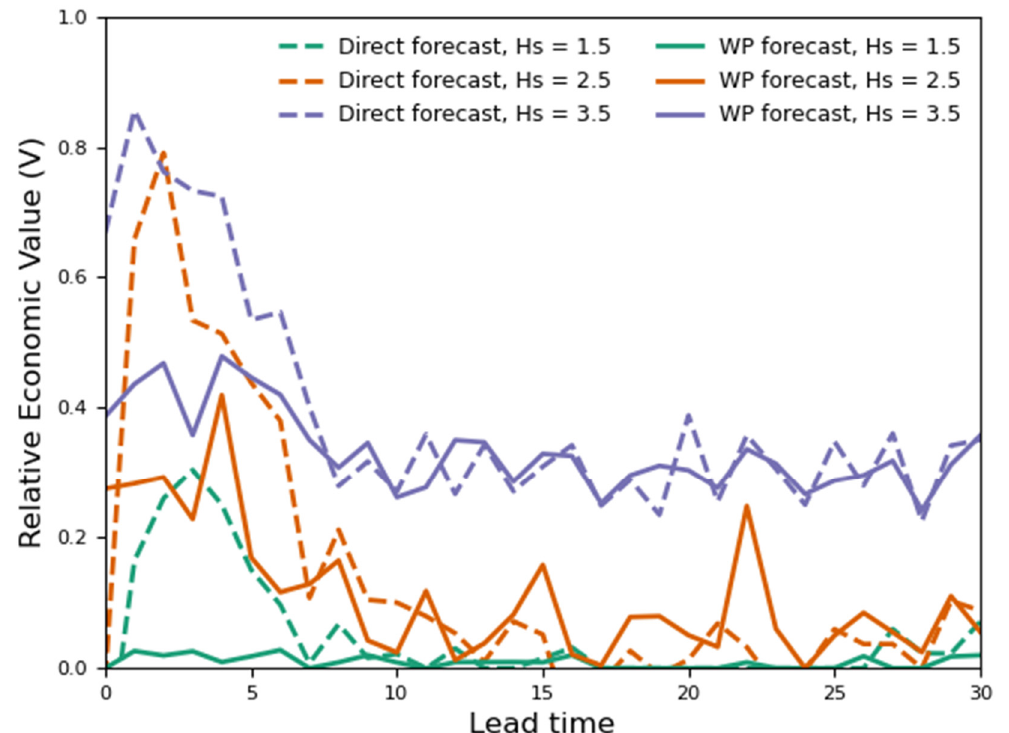
Figure 2. Relative Economic Value of ensemble significant wave height (Hs) forecasts with lead times up to 30 days calculated for a cost/loss (C/L) ratio of 0.1 at a North Sea location corresponding to Hs thresholds of 1.5 (green), 2.5 (orange), and 3.5 (purple) meters. Direct forecasts (dashed lines) are shown together with those for the weather pattern (WP)-derived forecasts (solid lines).